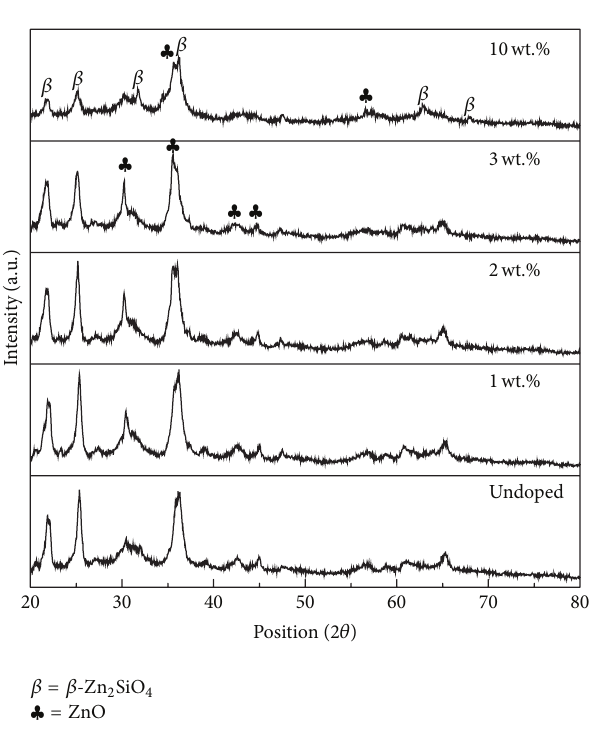
Figure 1: XRD pattern of undoped and Mn-doped Zn 2 SiO 4 based glass-ceramic sintered at 600 ∘